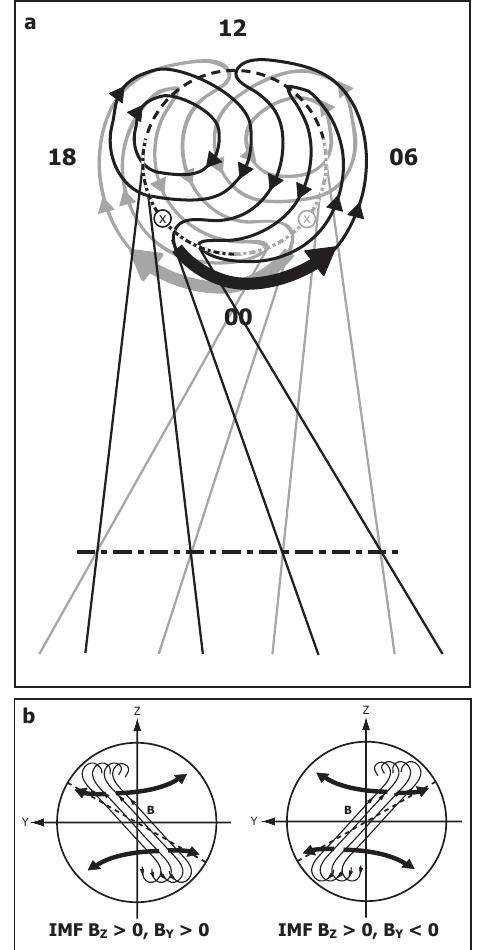
Fig. 3. Schematic representation of “TRINNI” field line topology in the magnetotail responsible for producing the flow bursts. (a) A view looking down on the Earth’s poles from the north with noon to the top and dusk to the left. The southern pole is thus viewed as if looking through the Earth. The open-closed field line boundary is shown as a dashed line and the reconnection line is dot-dashed. The solid arrowed curves show the convection streamlines for the northern (southern) IMF B y -positive (-negative) case in black and the southern (northern) IMF B y -positive (-negative) case in grey. The thick large arrows depict the flow bursts themselves. Tail field lines are represented by the straight lines which connect the two hemispheres via the reconnection line. (b) The corresponding view towards the Earth from the tail for the 2 orientations of IMF B y . The twisted neutral sheet is indicated by the dashed line and newly reconnected (closed) field lines ( B ) are indicated. Convection return flows are shown by arrows (after Nishida et al., 1998; Grocott et al., 2004; Milan et al.,